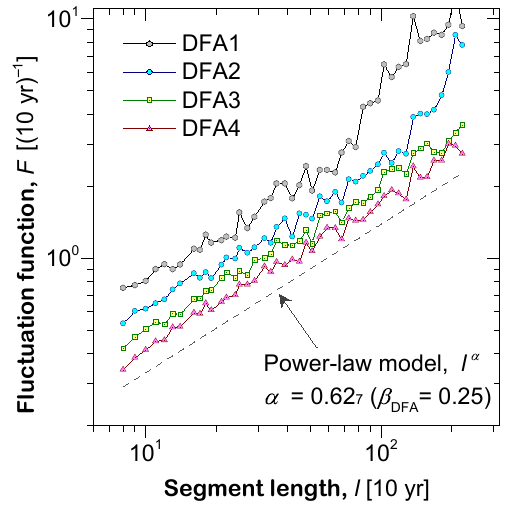
Figure 8. Detrended fluctuation analysis (DFA) of the 9271-year Piànico–Sèllere, Italy, palaeoflood record: the fluctuation function F for the number of floods per decade shown as a function of the segment length l and for different orders of the detrending (see the legend) on a double logarithmic scale. Segments contain- ing parts of or the entire gap were excluded. Also shown are the best-fitting power-law function (Eq. 12) for DFA3 and the cor- responding power-law exponent α and its corresponding value of β DFA = 2 α −